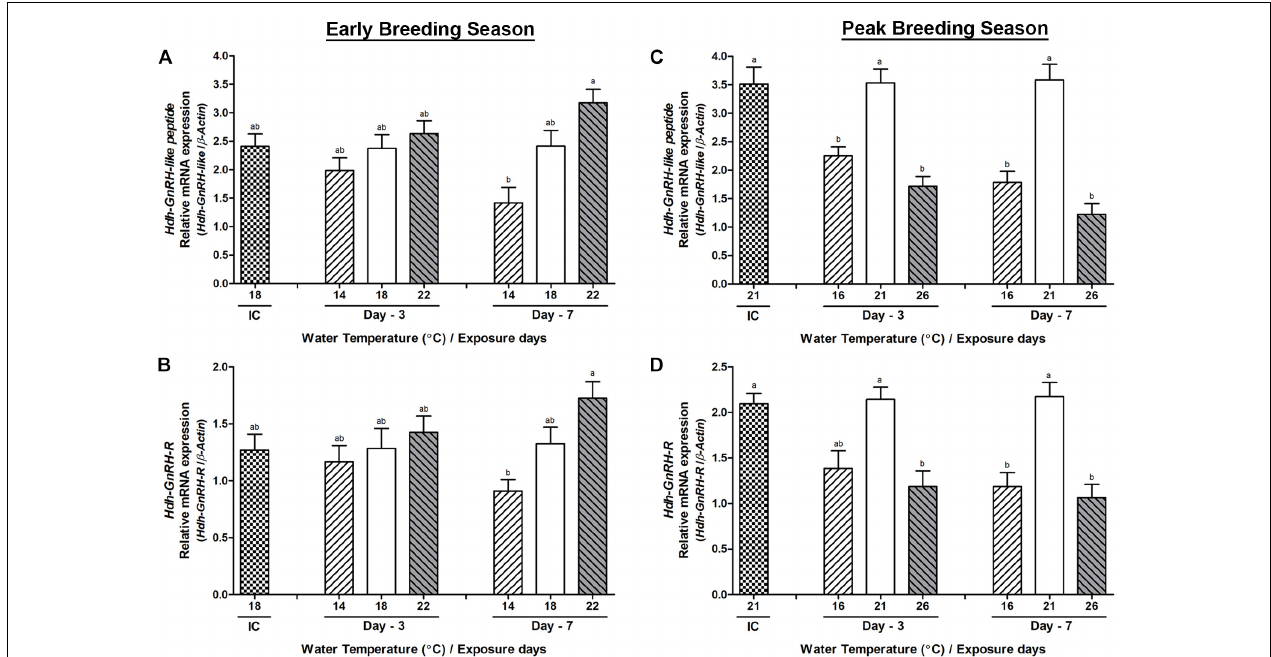
FIGURE 3 | Changes in the relative mRNA expression of Hdh-GnRH-like peptide (A,C) and Hdh-GnRH-R (B,D) in the cerebral ganglion (CG) of male Pacific abalone during early and peak breeding seasons after exposure to thermal stress for 7 days. Before exposure to the target temperature of thermal stress, abalone were sampled to obtain reference values that served as initial control (IC). Values represent the mean ± SD ( n = 10). Different letters on the bar indicate significant differences among different temperature groups ( p < 0.05).